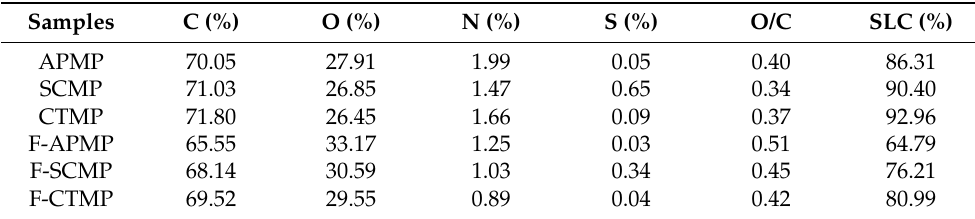
Table 3. XPS analysis of the surface elements and lignin contents of pulp.